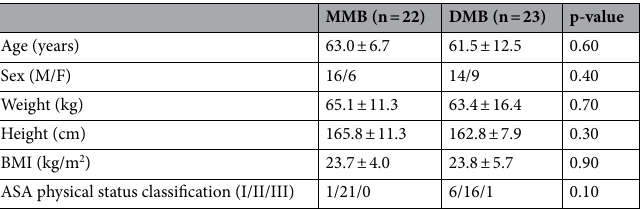
Table 2. Patients demography and characteristics (n = 45). M male, F female, BMI Body Mass Index, ASA American Society of Anesthesiologists.